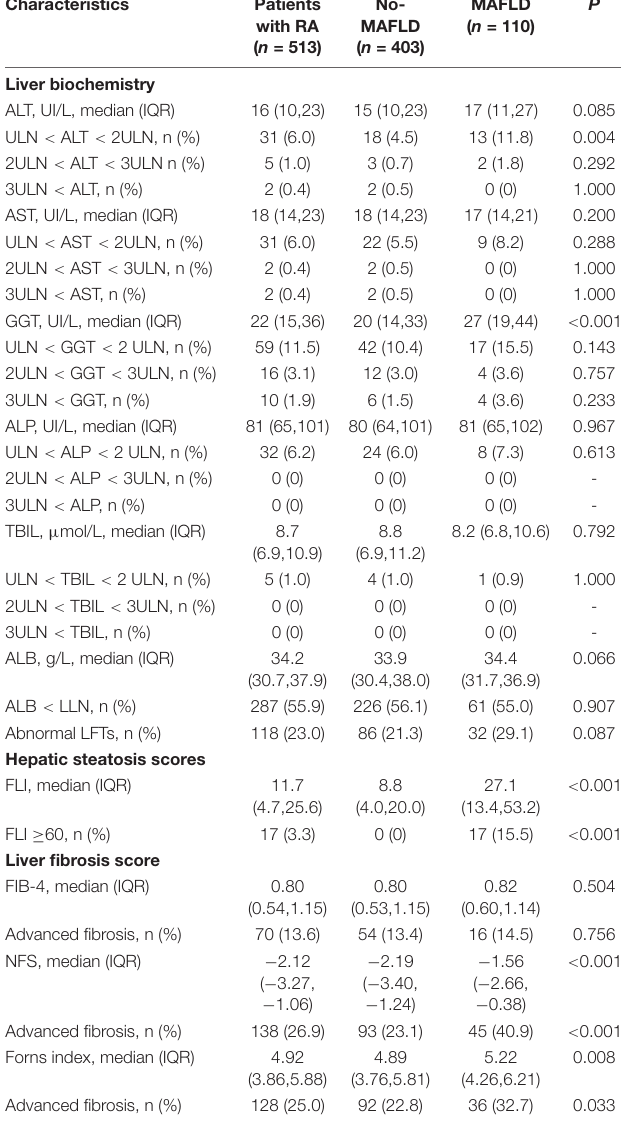
TABLE 2 | Comparisons of liver biochemistry and fibrosis indices between RA patients with and without MAFLD. Characteristics